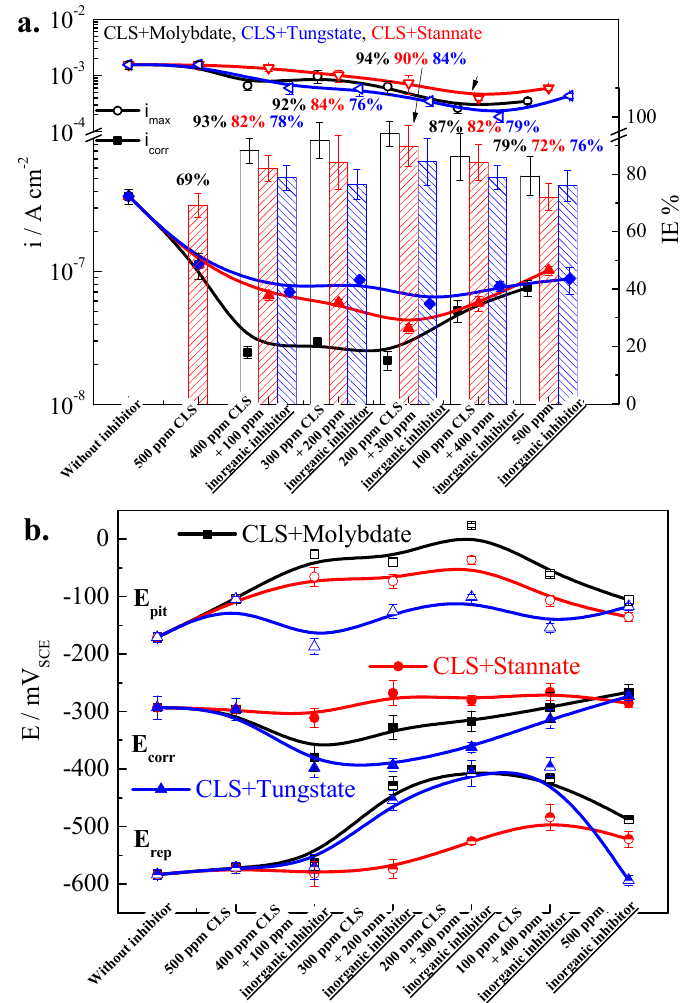
Figure 4. Electrochemical parameters of CPP curves for compound inhibitors: ( a ) E ocp , E pit , and E rep ; ( b ) i corr , i max , and IE%.